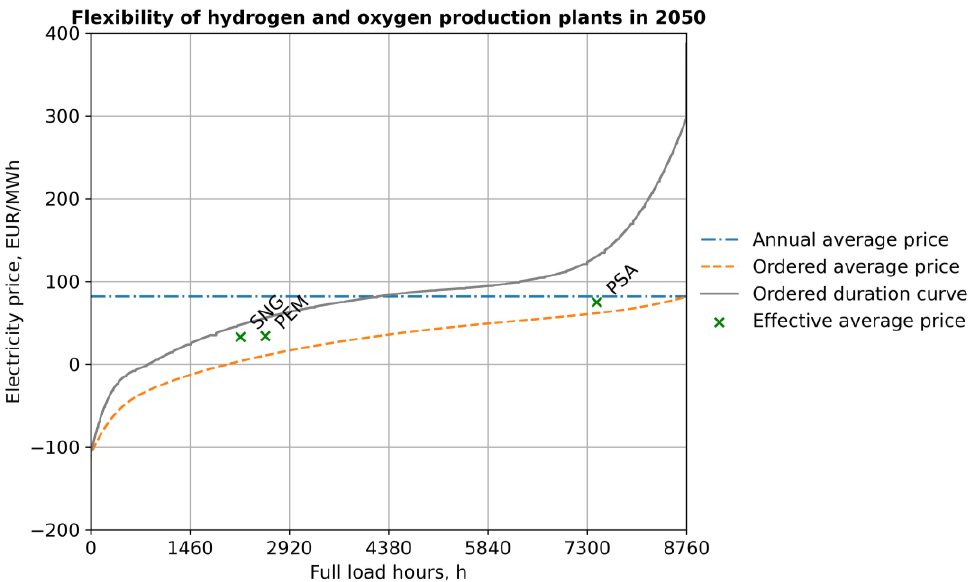
Figure 8. Purchased electricity price in relation to full-load hours.